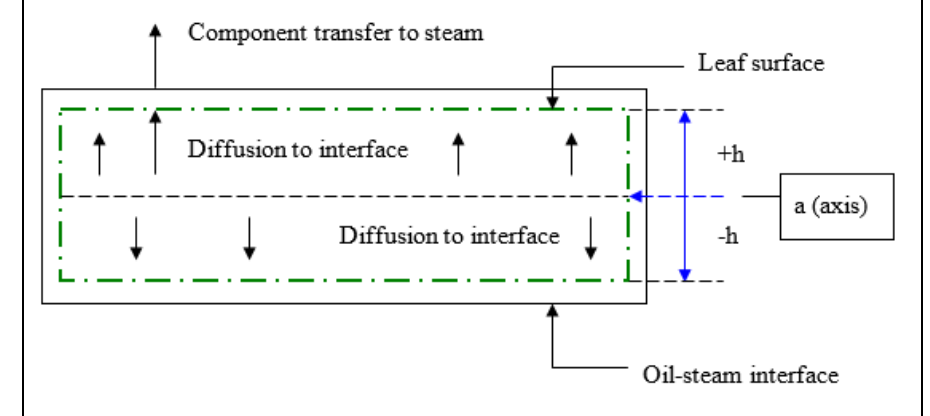
Figure 2. Component transfer mechanisms from leaf to steam.